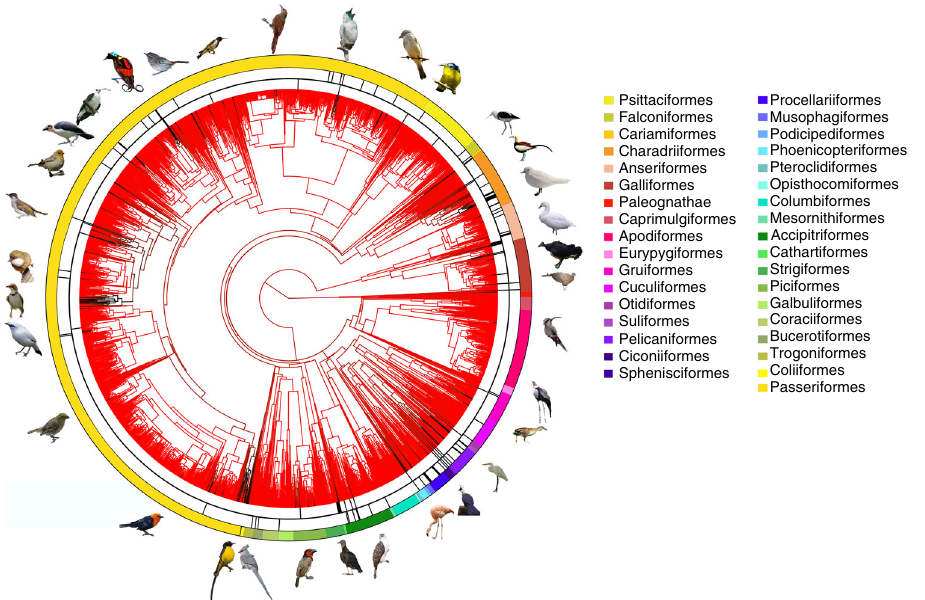
Fig. 2 Ancestral state estimation for black skin of the heads of male birds. Branches of the phylogenetic tree are black when the reconstructed skin colour was black, and red when this was non-black. Black bars in the fi rst circle represent species that are bald, while black bars in second circle represent species that have white feathers. All photographs were edited such that the background was removed. Photographs were taken by U.S. Fish & Wildlife Service ( Telespiza cantans ), Kenvanportbc ( Amblyramphus holosericeus ) and Adrian Pingstone ( Coscoroba coscoroba ) in the public domain, by Hector Bottai ( Hylexetastes perrotii , Hapalocrex fl aviventer ) and Charles J Sharp ( Ardea alba ) under CC BY-SA 4.0 (https://creativecommons.org/licences/by-sa/4.0/), by Thai National Parks ( Hemixos fl avala ), birdphotos.com ( Bugeranus carunculatus ) and Dubi Shapiro ( Neodrepanis hypoxantha ) under CC BY SA